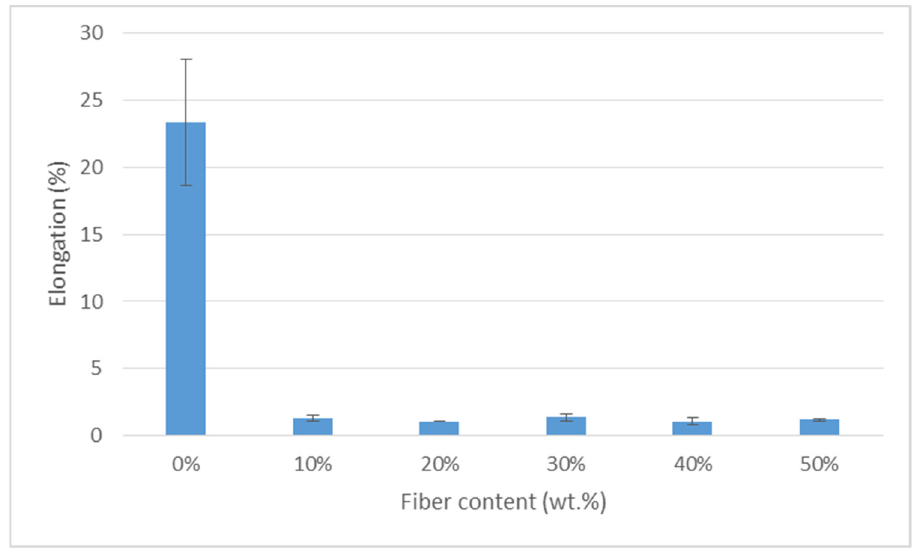
Figure 5. Elongation at break of TPCS/BLF composites.